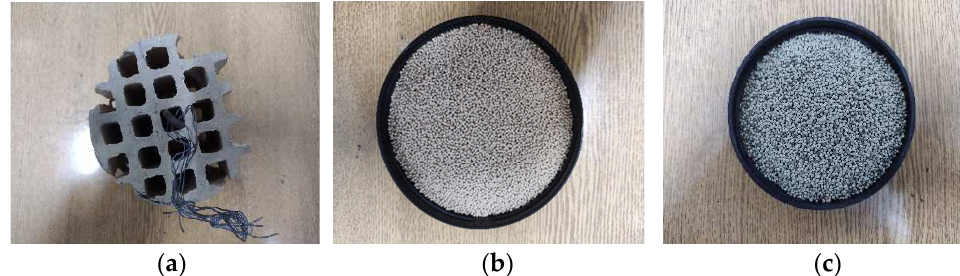
Figure 4. Catalysts used in the measurements: ( a ) platinum catalyst on ceramic carrier; ( b ) molecular sieve; ( c ) molecular sieve with copper(II) oxide.